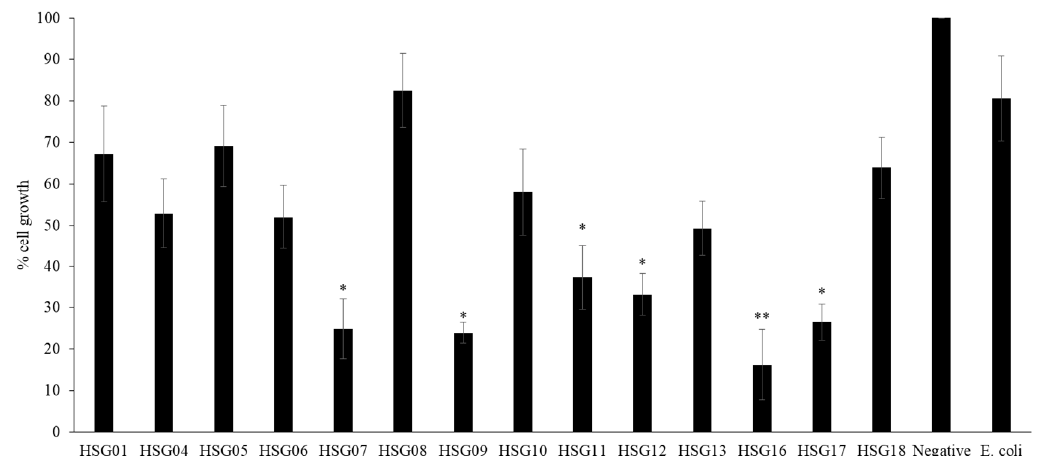
Figure 2. The growth inhibition effect of conditioned media prepared from bacteria isolated from the gastrointestinal tract of scorpion, H. spinifer against HeLa cells as described in Materials and Methods. The results represent mean ± standard error of three sets of experiments performed in duplicate for HeLa cells; p value was determined using two sample T-test, two-tailed distribution, (*) is < 0.05 and (**) is < 0.005.